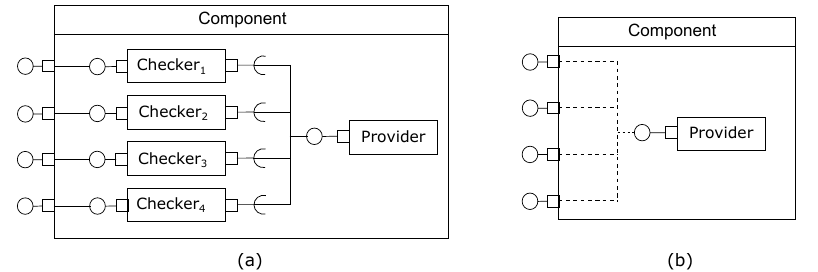
Figure 21. Discriminating between requesters to selectively accept requests from specific sources: ( a ) Existing design: Using dedicated objects to set the source field of incoming requests. ( b ) Updated design: Using an enhanced connector to set the source field of incoming